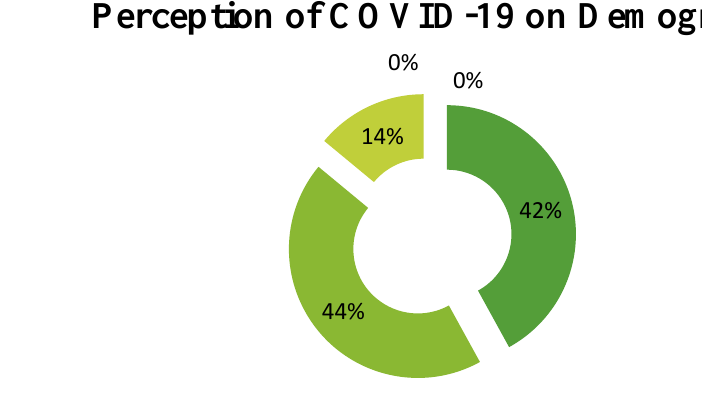
Figure 8 : The figure 8 shows the perception of entire respondents towards the impact of COVID-19 on demographic dividend of Bangladesh. Among the 150 respondents none could identify any positive indication of COVID-19 on demographic dividend, where 21 respondents find it neutral by claiming that the higher degree usage of technological devices equalizes the negative impact, on the contrary 66 respondents find the impact of COVID-19 on demographic dividend has adverse impact and 63 respondents labeled the impact as highly